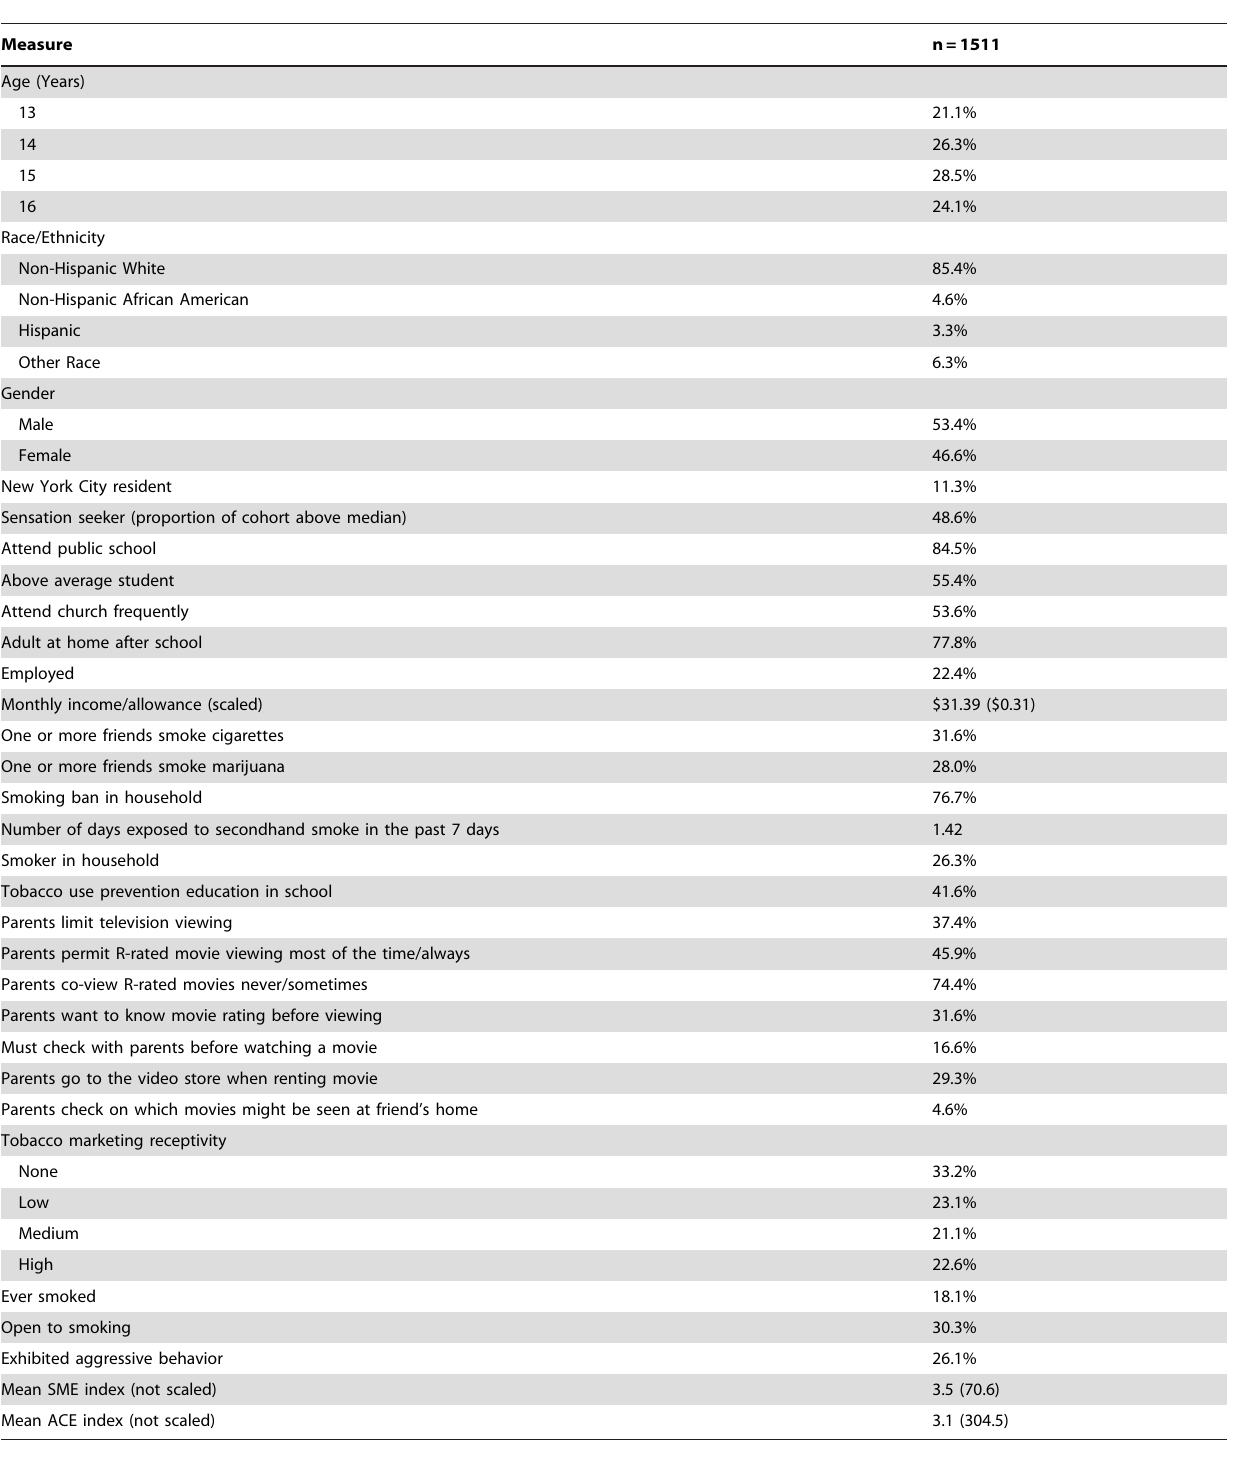
Table 1. Baseline Demographics and Summary Statistics from the New York Longitudinal Youth Tobacco Evaluation Survey (NY- LYTES),